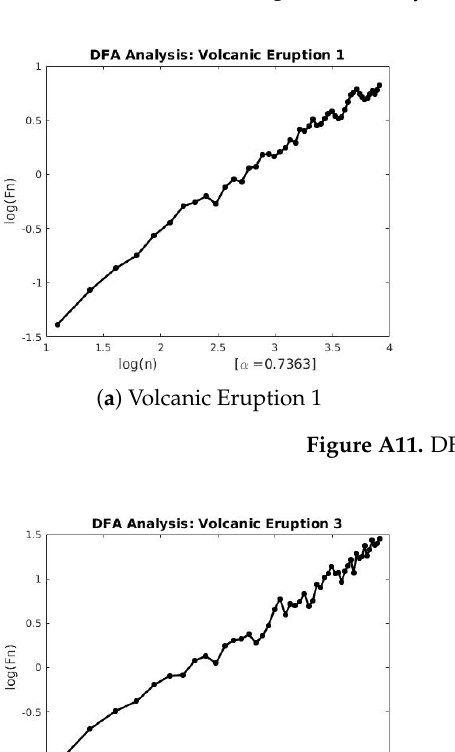
Figure A10. Lévy model fit for Volcanic Eruptions 7 and 8.